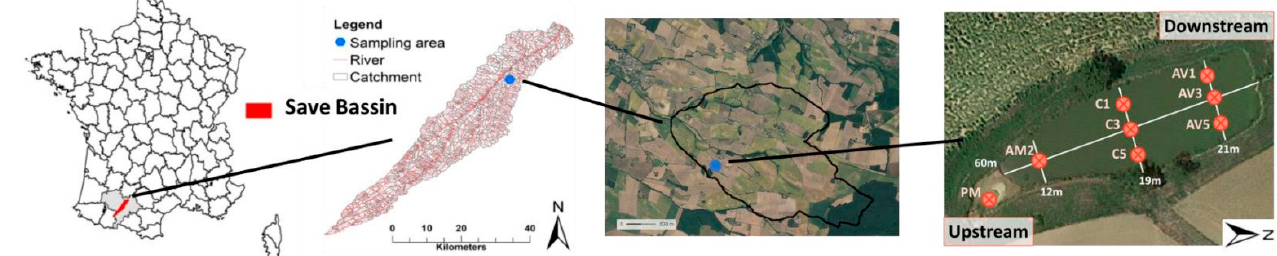
Figure 1. Location of the field study site at (from left to right): country scale, basin scale from Wu PhD, sub-catchment scale (map from Google map) and pond scale (map from Google map) with sampling points.